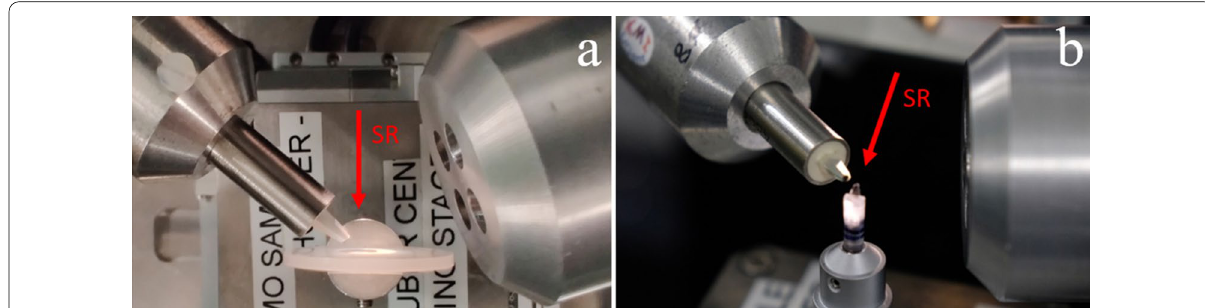
Fig. 1 XRF detection setup used at beamline P06 to analyse a Ryugu sections C0033‑01 and C0033‑04 fixed in epoxy disks and b the geological glass reference material ATHO‑G. Confocal SDD detector on the left, 4‑element SDD detector on the right. Both are positioned, respectively, under opposite angles of 47° and 72°. The incident SR beam is indicated with a red